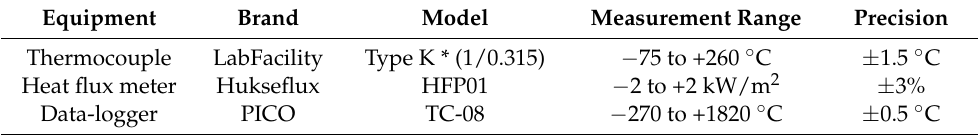
Table 2. Characteristics of the measurement equipment used in the lab experiments. Equipment Brand Model Measurement Range Precision Thermocouple